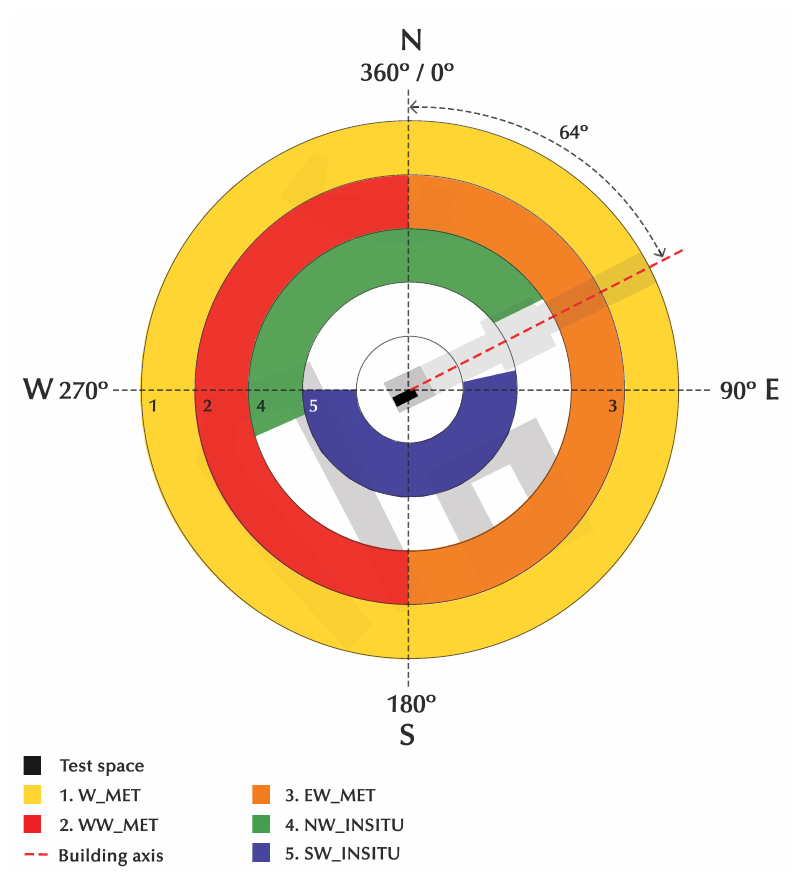
Figure 5. Graphical representation of selected wind speed data. W_MET is the weather station winds (herein as global wind) from 0º to 360º; WW_MET and EW_MET are the weather station west and east winds from 181º to 360º and 0º to 180º, respectively; NW_INSITU is the wind data recorded by the wind speed sensor on the northwest terrace; SW_INSITU is the wind data collected on the southeast